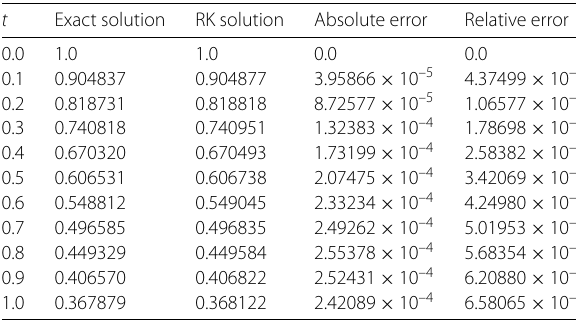
Table 5 Absolute and relative errors of Example 5.3 at α =